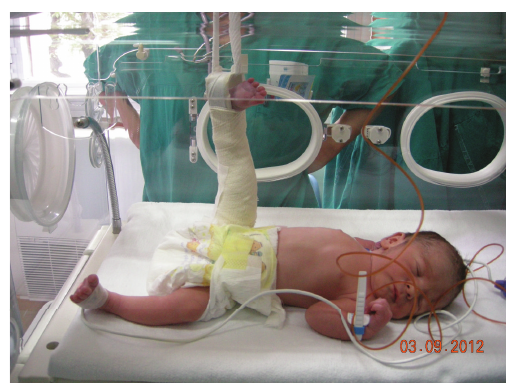
Figure 2: Immobilization of the right leg in extension.